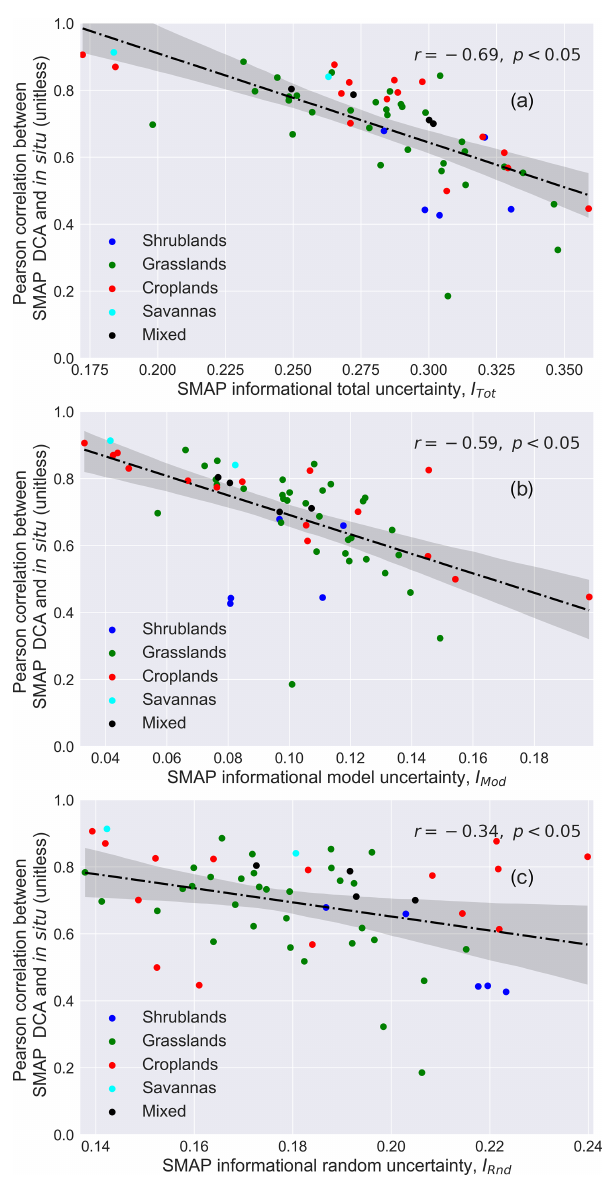
Figure 5. SMAP informational total uncertainty (a) , SMAP in- formational model uncertainty (b) , and SMAP informational ran- dom uncertainty (c) against Pearson correlation between in situ soil moisture and DCA soil